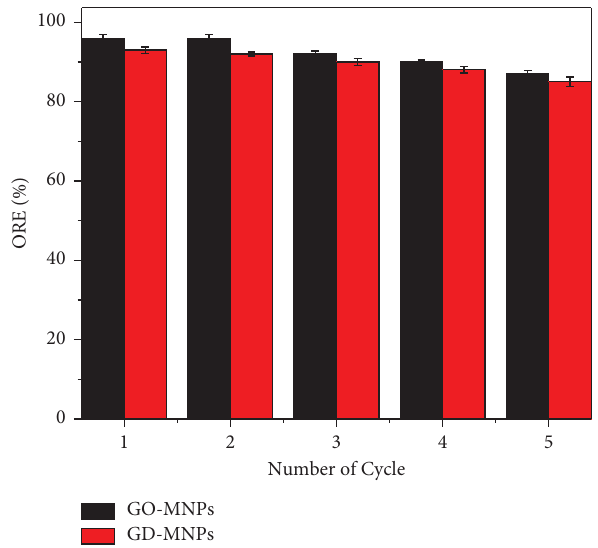
Figure 11: Reusability of GO-MNPs and GD-MNPs using MNP : crude oil ratio of 1 :4 using method